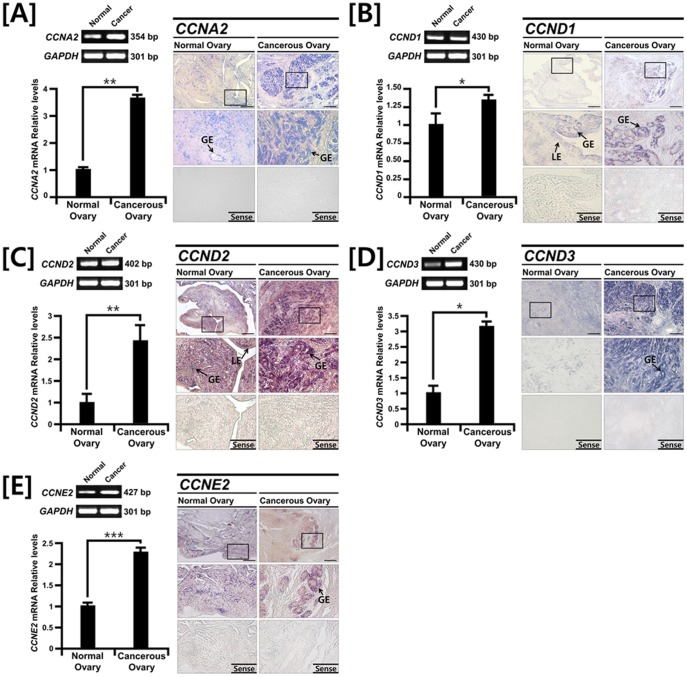
Comparative expression patterns for CCNA2, CCND1, CCND2, CCND3 and CCNE2 mRNAs in normal and cancerous ovaries from laying hens.RT-PCR and quantitative RT-PCR analysis were conducted using cDNA templates from normal and cancerous ovaries of laying hens using chicken CCNA2, CCND1, CCND2, CCND3 and CCNE2 and chicken GAPDH specific primers (left panel). These experiments were conducted in triplicate and values normalized to those for GAPDH. In situ hybridization analysis indicates cell specific expression patterns for CCNA2, CCND1, CCND2, CCND3 and CCNE2 mRNAs in both normal and cancerous ovaries from laying hens (right panel). See Materials and Methods for complete description.